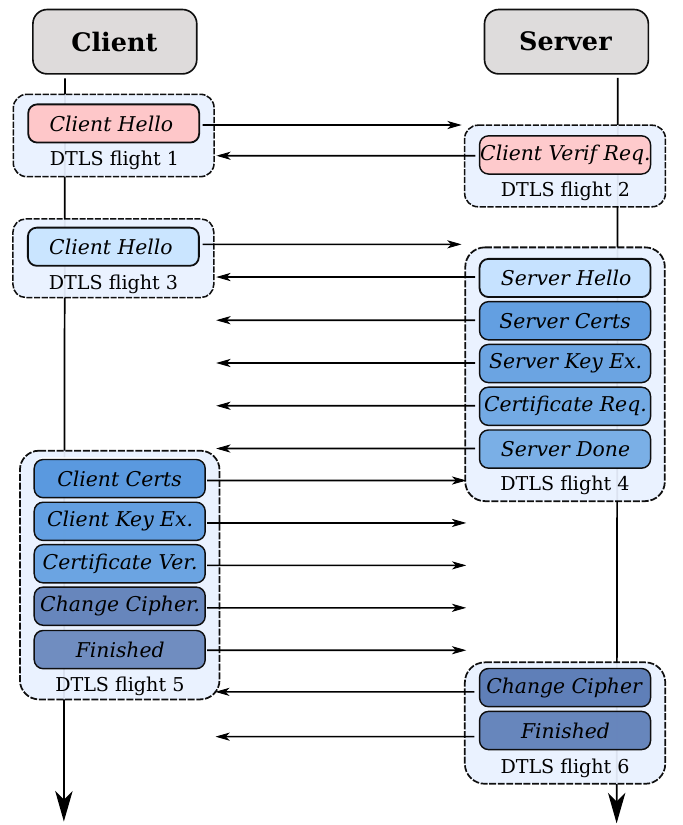
Figure 2. The (D)TLS handshake protocol. The initial two messages are only available when DTLS enforces Denial-of-Service